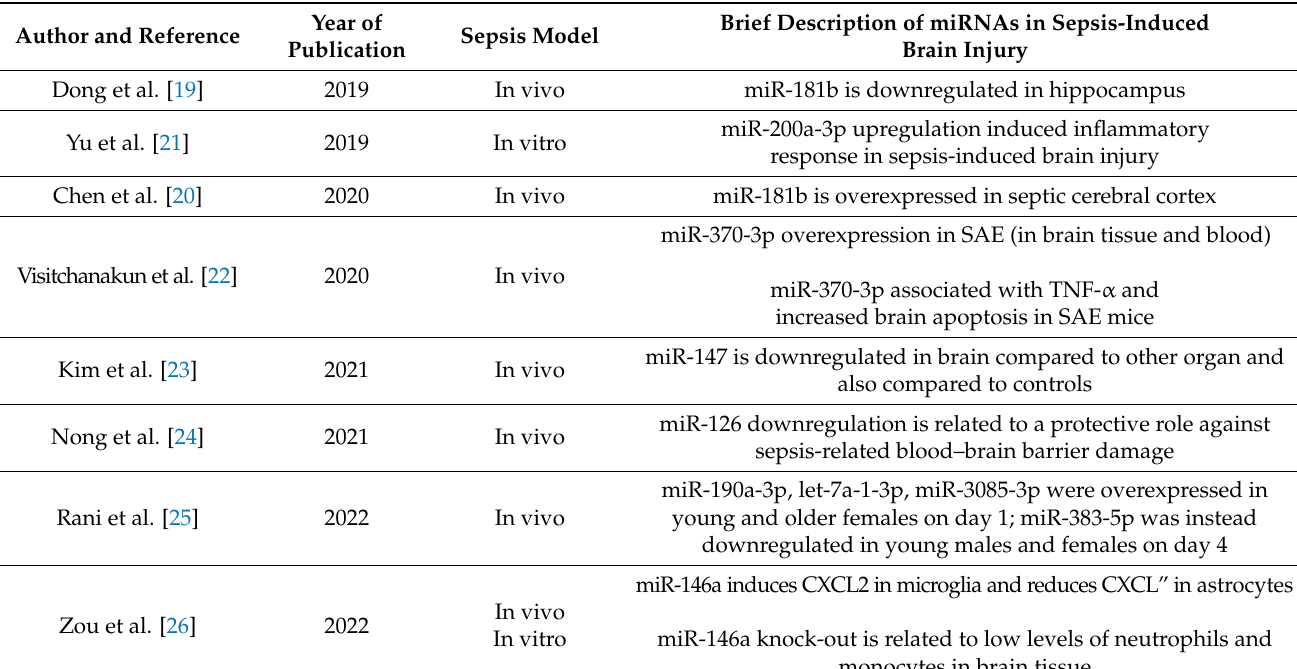
Table 1. miRNA expression in sepsis-related brain